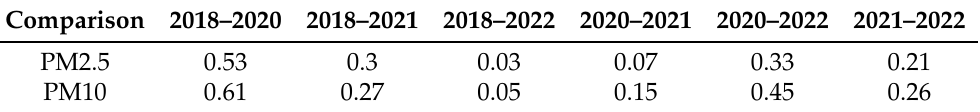
Table 5. The effect size of COVID-19 pandemic. The pandemic had a large positive effect on air pollution in 2020 compared to 2018. This effect was gradually reduced in 2021, while the effect is small to insignificant when 2018 and 2022 are compared. Similar results are obtained when 2022 is compared to 2020 and 2021. The effect is small to insignificant when 2018 and 2022 are compared, as well as when 2020 and 2021 are